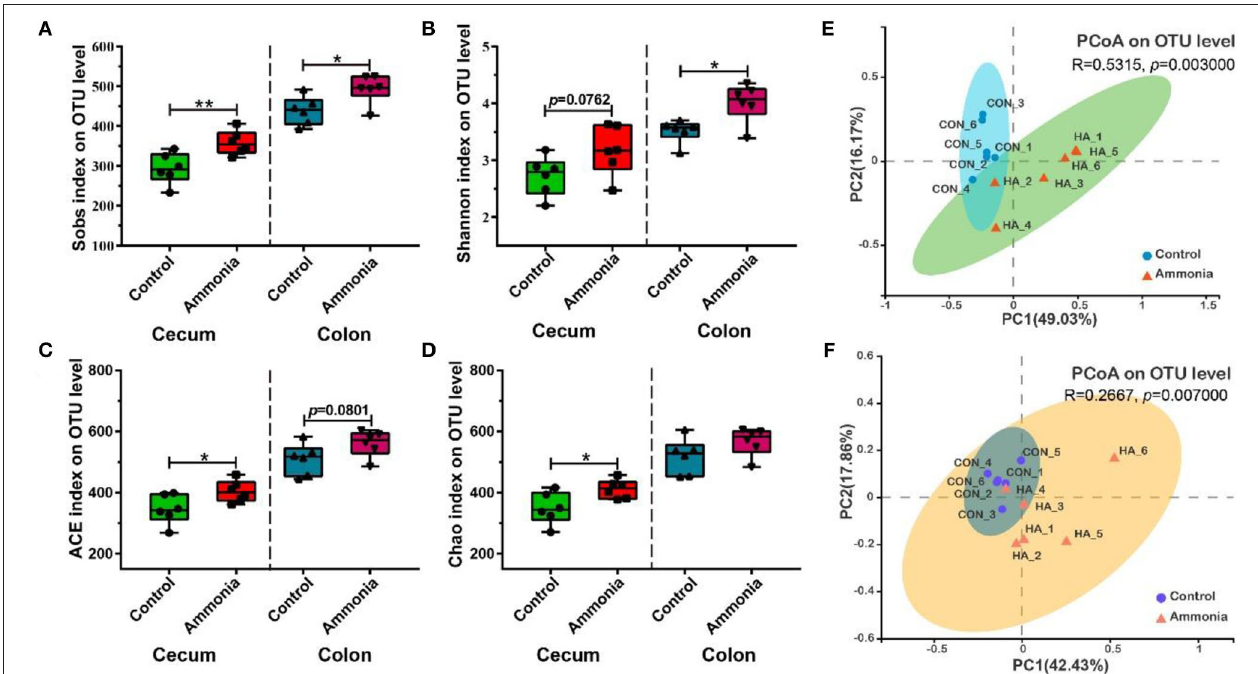
FIGURE 3 | Alpha and beta diversities of the microbial community in the cecum or colon digesta after ammonia exposure. (A) The Sobs, (B) Shannon, (C) ACE, and Chao indexes in the cecum or colon among two groups; PCoA (OTU level) of community membership based on the Bray–Curtis distance and ANOSIM test in (E) cecum and (F) colon. Data are expressed as min to max showing all points ( n = 6), * p < 0.05, and ** p <